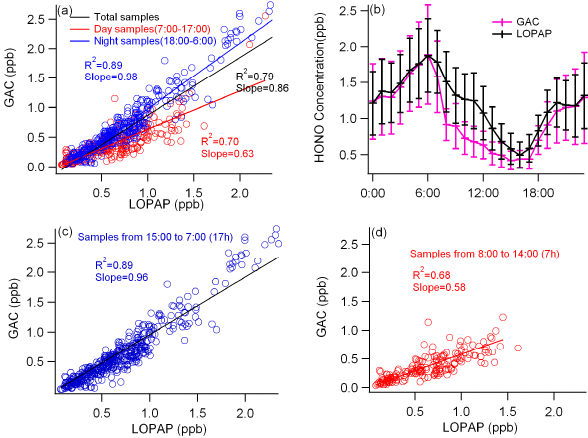
Fig. 11. The inter-comparison between the GAC-IC and the Fig.11. The inter-comparison between the GAC-IC and the LOPAP: (a) LOPAP: (a) inter-comparison of day samples from 07:00 to 17:00 inter-comparison of day samples from 7:00 to 17:00 (11 hours) and night samples (11h) and night samples from 18:00 to 06:00 (13h); (b) diur- nal variations of GAC-IC and LOPAP measurement; (c) inter- from 18:00 to 6:00 (13 hours); (b) diurnal variations of GAC-IC and LOPAP comparison of samples from 15:00 to 07:00 (17h); (d) inter- measurement; (c) inter-comparison of samples from 15:00 to 7:00 (17 hours); (d) comparison of samples from 08:00 to 14:00 inter-comparison of samples from 8:00 to 14:00 (7 hours).